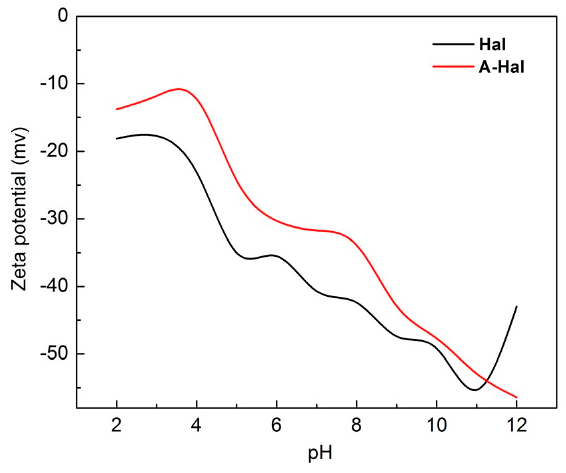
Figure 1. Zate potential plot of the Hal and A-Hal samples.